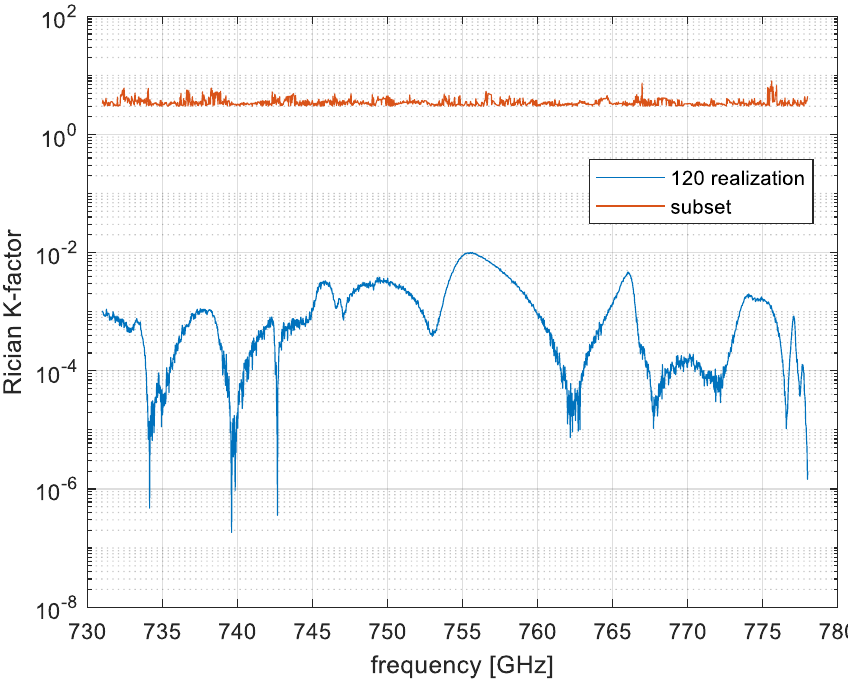
Figure 8. Rician K-factor frequency behavior with the 120 field configurations and after having applied the algorithm in the frequency band 711–778 MHz.